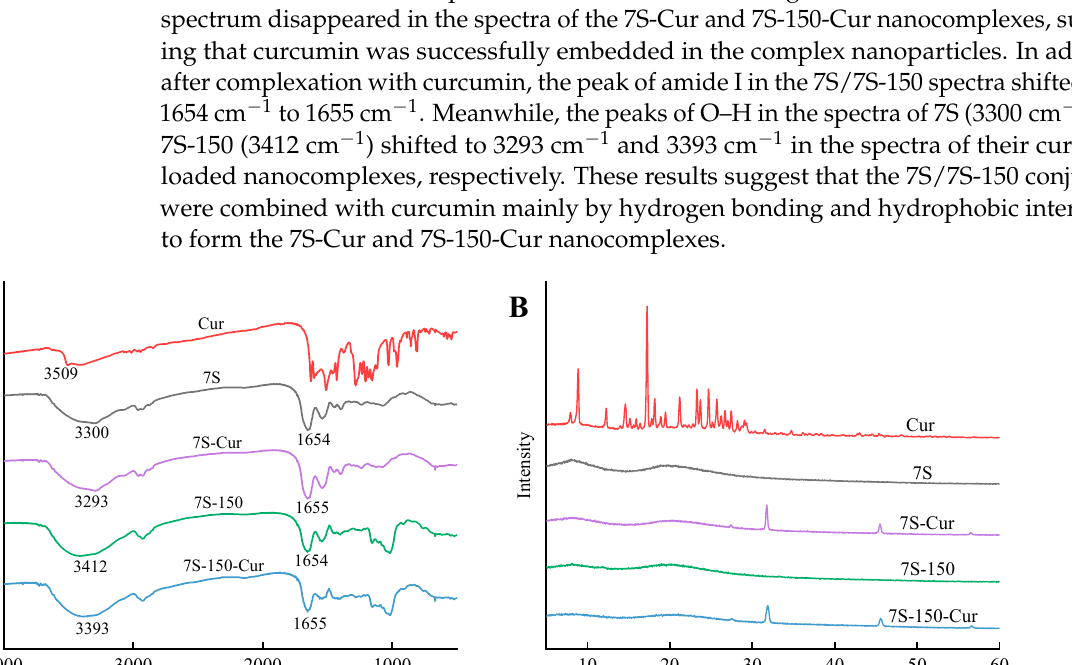
Table 2. The Z-average diameter, polydispersity index (PDI), ζ -potential, encapsulation efficiency (EE%), and loading amount (LA) of the 7S-Cur and 7S-150-Cur nanocomplexes prepared at 25 ° C.